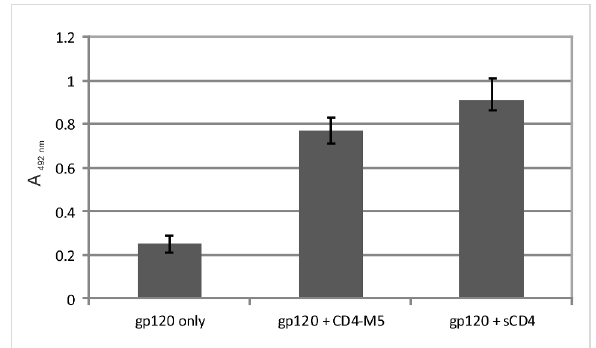
Figure 4: Enhancement of binding of gp120(MN) to the CD4i antibody X5 by CD4-M5 and sCD4, respectively. See Experimental section for details of the binding